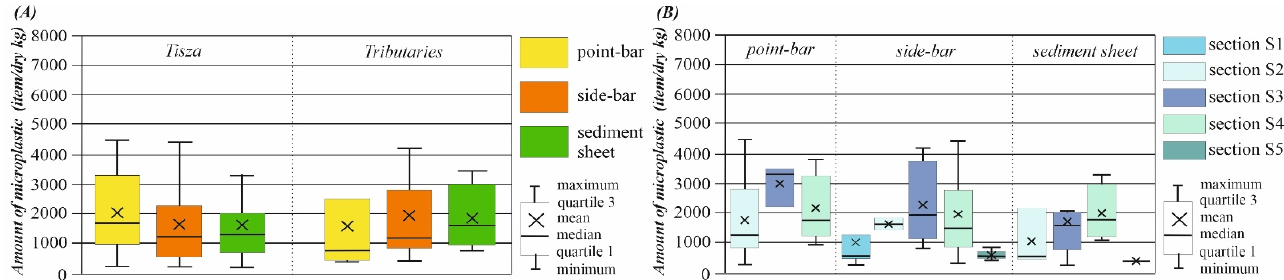
Figure 6. Differences in microplastic content (item/dry kg) of the sediments of the Tisza River and its tributaries ( A ) and of various geomorphological forms sampled at the various sections of the Tisza River ( B ).